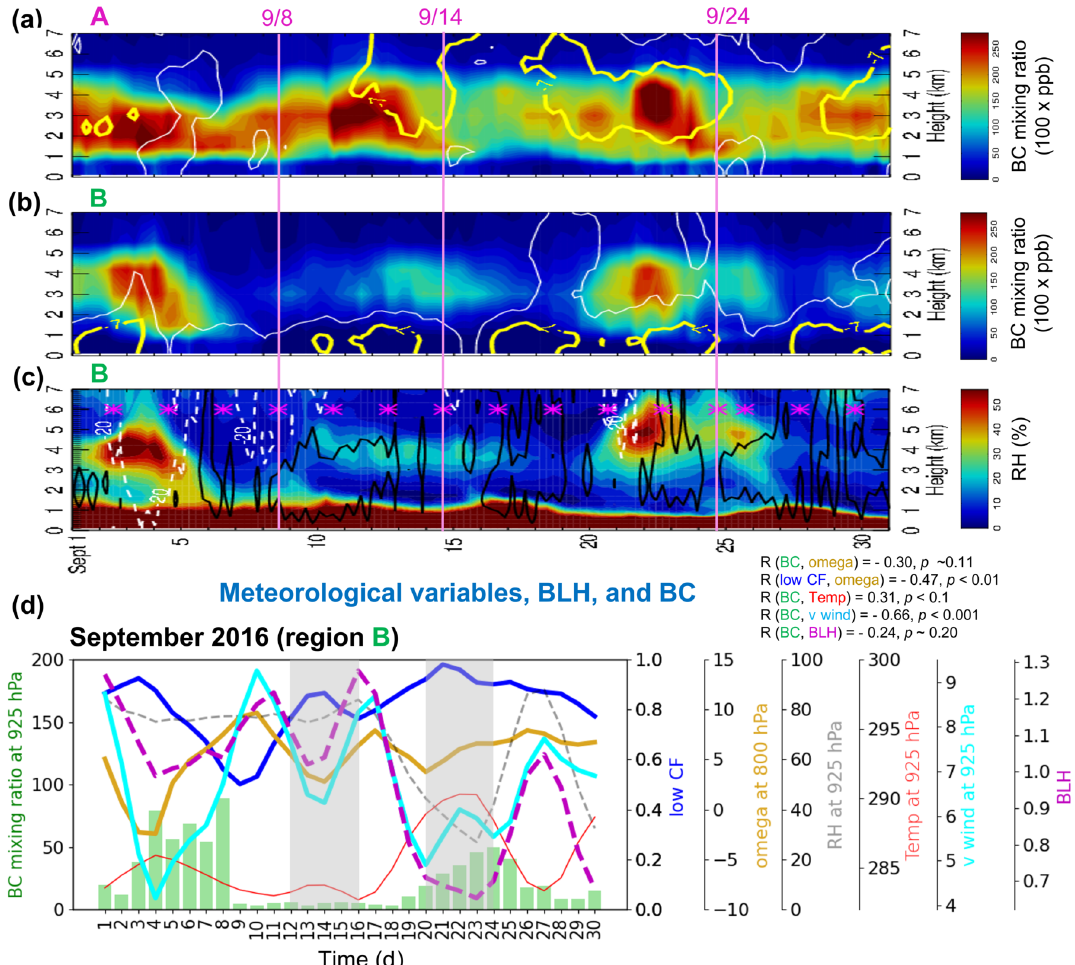
Figure 4. (a, b) Time–altitude cross section of every 6h of BC (shading; ppb × 100) overlaid by zonal wind isotachs at − 7 and 0ms − 1 (thick yellow and thin white lines, respectively) averaged over (a) region A (0–10 ◦ E, 5–15 ◦ S) and (b) region B (0–10 ◦ E, 15–25 ◦ S) in September 2016 for every 6h. (c) The same as panel (b) but for every 6h of RH (shading; %) overlaid by every 6h of vertical velocities of − 20 and 50hPad − 1 (dashed white and solid black lines, respectively; positive values represent subsidence) averaged over region B. (d) Time series of daily mean 925hPa BC (green bar; ppb × 100), 800hPa vertical velocity (omega; ω ; gold line; hPad − 1 ), 925hPa RH (dashed gray line; %), 925hPa temperature (solid red line; K), 925hPa meridional wind (solid cyan line; ms − 1 ), BLH (dashed magenta line; km), and low CF (blue line) over region B. Each colored line represents the 3d running mean. The asterisk in panel (c) represents the September 2016 flight days. The pink solid lines in panels (a) – (c) refer to the 3 flight days. The light gray shadings in panel (d) represent the two periods having different BC–RH conditions. R in panel (d) refers to the Pearson correlation coefficient between two variables in a parenthesis with its statistical significance ( p